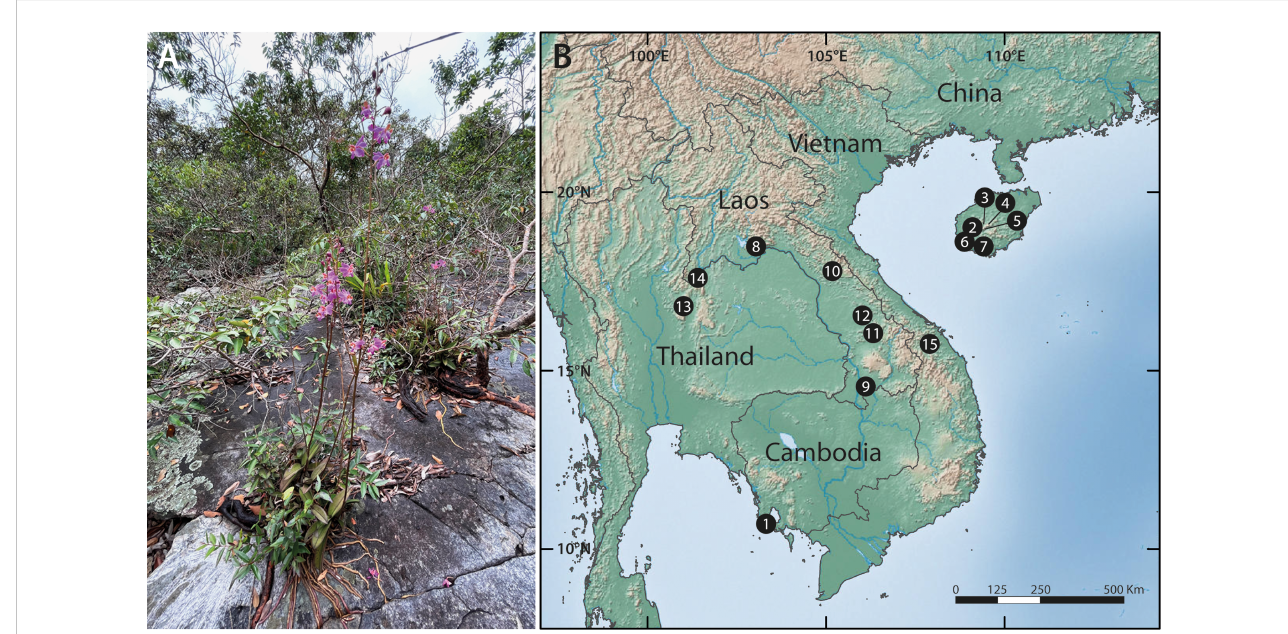
FIGURE 1 Typical habit and habitat of Phalaenopsis pulcherrima and geographic scope of the study. (A) Plants growing in a shallow depression on a granitic inselberg in northeast Thailand. Note the long, velamentous roots directly attached to the substrate. Photo: T. Sando. (B) Location of the 15 inselbergs included in this study; see Table 1 for information on the populations sampled at each